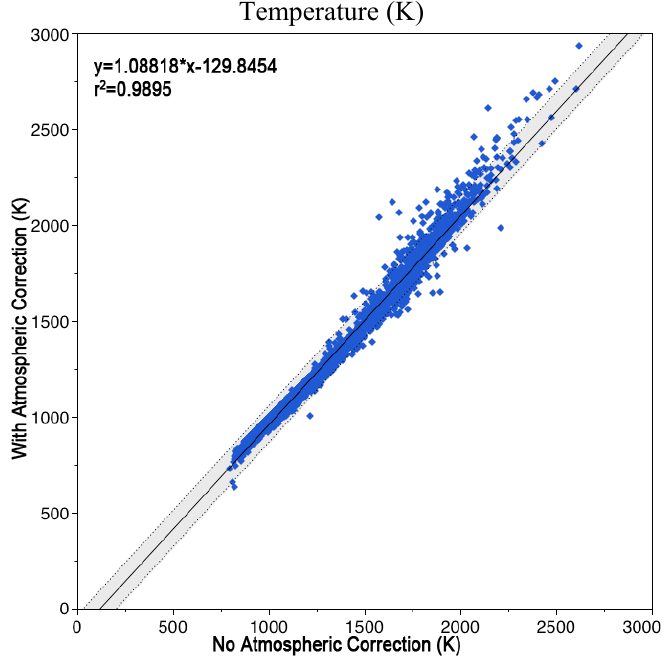
correction from 4 April 2013. The shaded area encompasses the 99% confidence interval around the regression